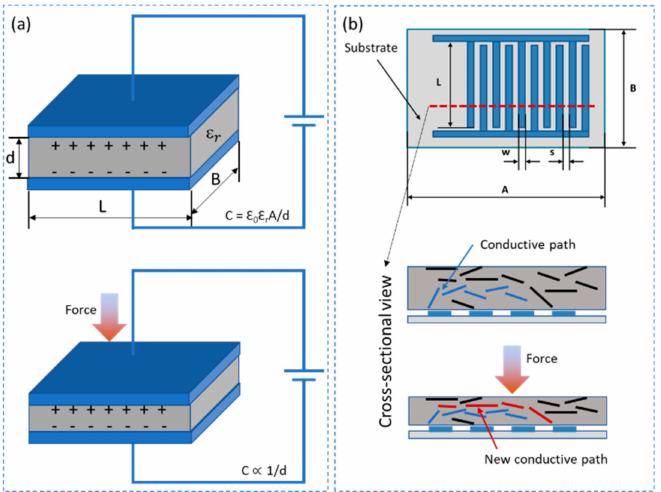
Figure 4. Conduction mechanisms of polymer/CNT pressure sensor based on piezocapacitive working principle: ( a ) sensors based on parallel plate electrode structures and ( b ) sensors based on interdigital electrode